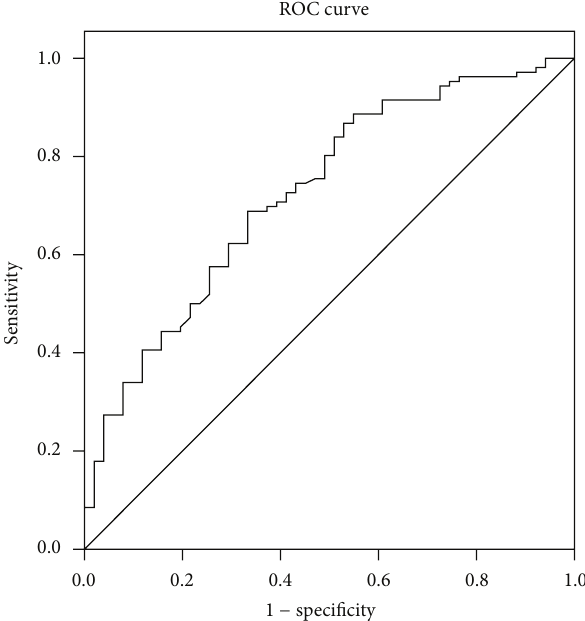
Figure 5: Receiver operator characteristic (ROC) curve indicated the predictive value of SDNN for long-term success of AF ablation. Area under the ROC curve was 0.71. The cut-off value was 91.9, with a sensitivity and specificity of 68.9% and